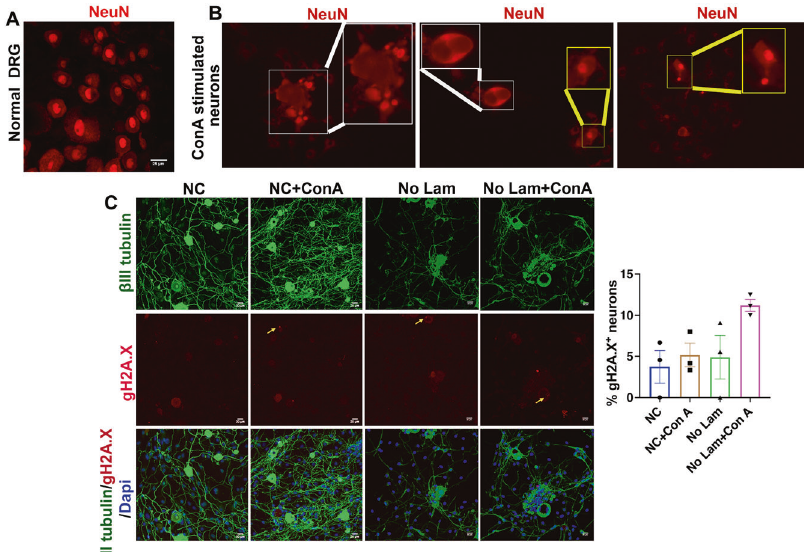
Fig. 3 Distribution of NeuN and expression of gH2A.X in stressed sensory neurons. A Distribution of NeuN in a normal DRG. B NeuN distribution in ConA stimulated adult sensory neurons. The neurons were cultured in the presence of ConA for 48 h in PLL coated but laminin devoid surfaces. Abnormal distribution of NeuN in large diameter neurons is shown in white boxes while stable nuclear distribution of NeuN in small diameter neurons is shown in yellow boxes. Insets show enlarged views. C Expression of the DNA damage marker gH2A.X (yellow arrow) in 7-day cultures at the indicated experimental conditions. The right panel shows the quanti fi cation and suggest no major induction of DNA damage in laminin deprived or ConA stimulated cultures compared to control, while an increased trend for DNA damage was observed in No Lam + ConA cultures [data presented as mean ± SEM; n = 3; ANOVA (Tukey ’ s multiple comparisons